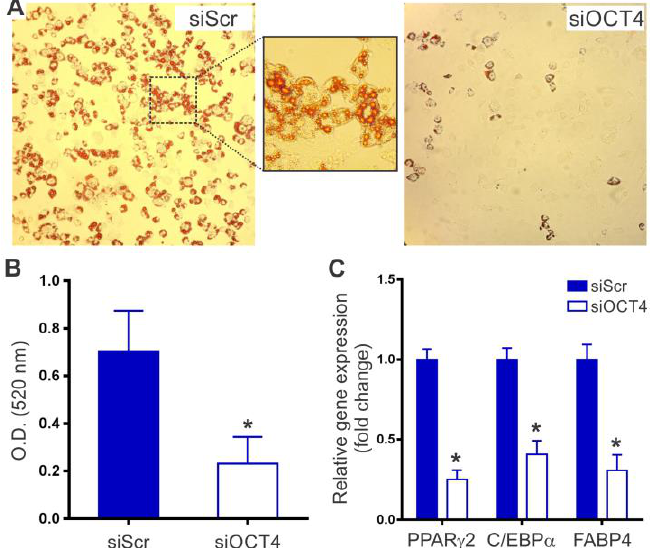
Figure 4. OCT4 silencing prevents MSC adipocyte differentiation. OCT4 siRNA (siOCT4) and scrambled siRNA (siScr) MSCs were tested for their ability to differentiate into adipogenic lineages by culture in differentiation medium for 15 days. ( A ) Representative images of Oil Red O staining to visualize lipid accumulation after 15 days of differentiation (magnification ×200). ( B ) Lipid accumulation was quantified by dye extraction and spectrophotometry at 520 nm. Results are expressed as mean ± SD ( n = 6 per group); * p < 0.001 derived from unpaired t -test. ( C ) Quantitative RT-PCR analysis of adipogenic markers at seven days after differentiation. Results are expressed as mean ± SD ( n = 4 per group); * p < 0.0001 between groups derived from unpaired t -test.